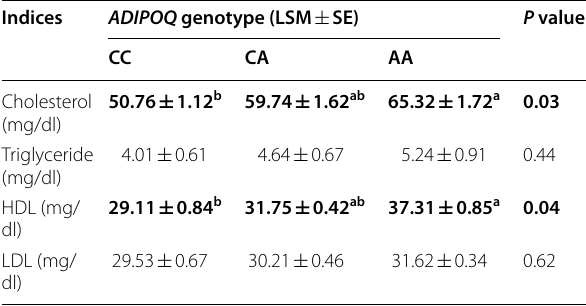
LSM SE least square means standard error. Different superscript in the same ± ± raw within each classification indicates significant differences ( P numbers indicates the P value with statistical significance. HDL high‑density lipoprotein, LDL low‑density lipoprotein